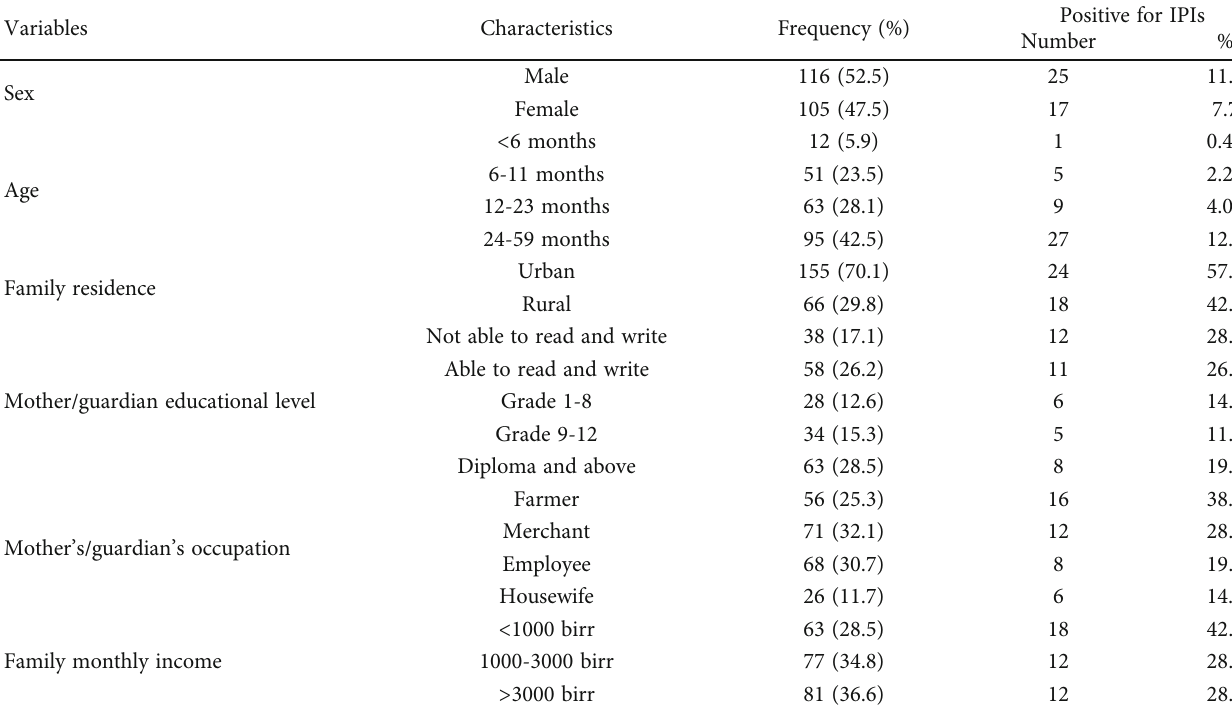
Table 1: Sociodemographic characteristics of study participants ( n = 221 ) at Bahir Dar and Han Health Centers, Northwest Ethiopia, 2020.